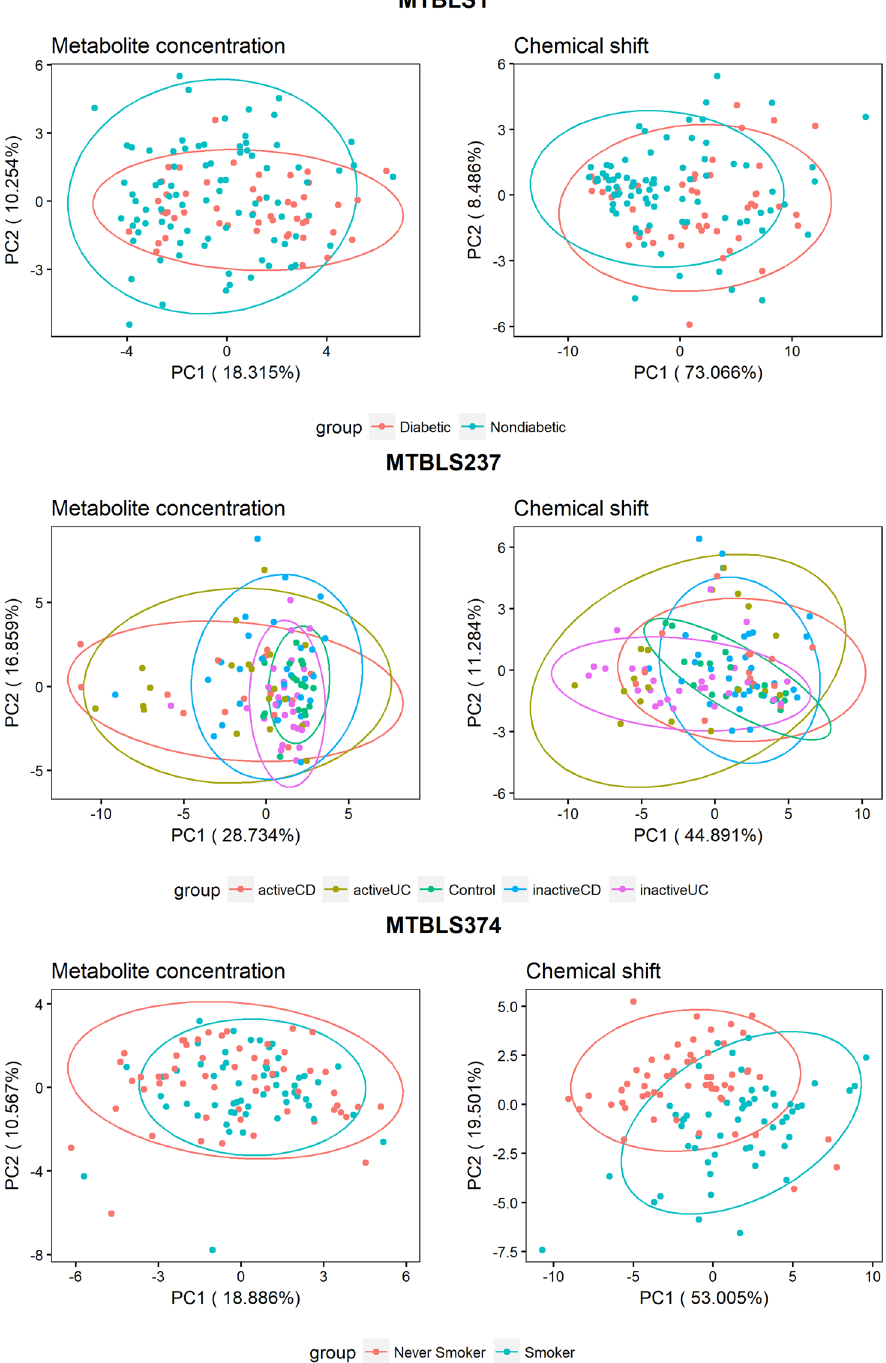
Figure 1. Exploratory PCA analysis shows the potential of the chemical shift data in the classificaton models. The first PCs of the PCA using chemical shifts (right) show better separation than the ones using concentrations (left). Plots also suggest no batch effects necessary to